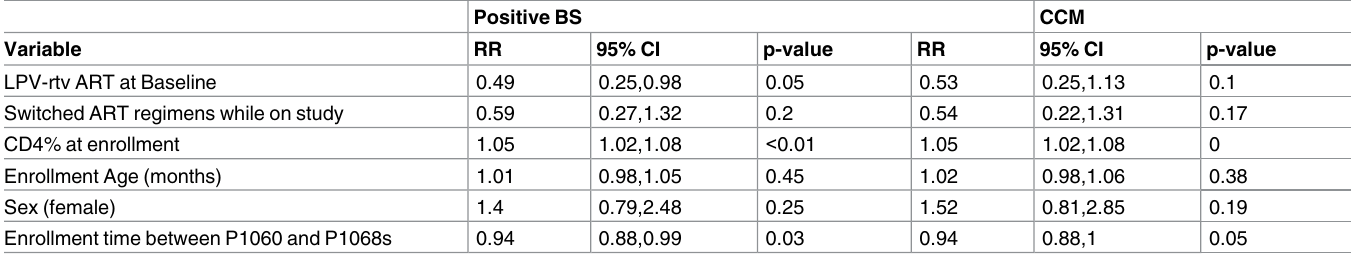
Table 4. As Treated Rates of Positive Blood Smears (BS) and Confirmed Clinical Malaria (CCM) (Negative Binomial